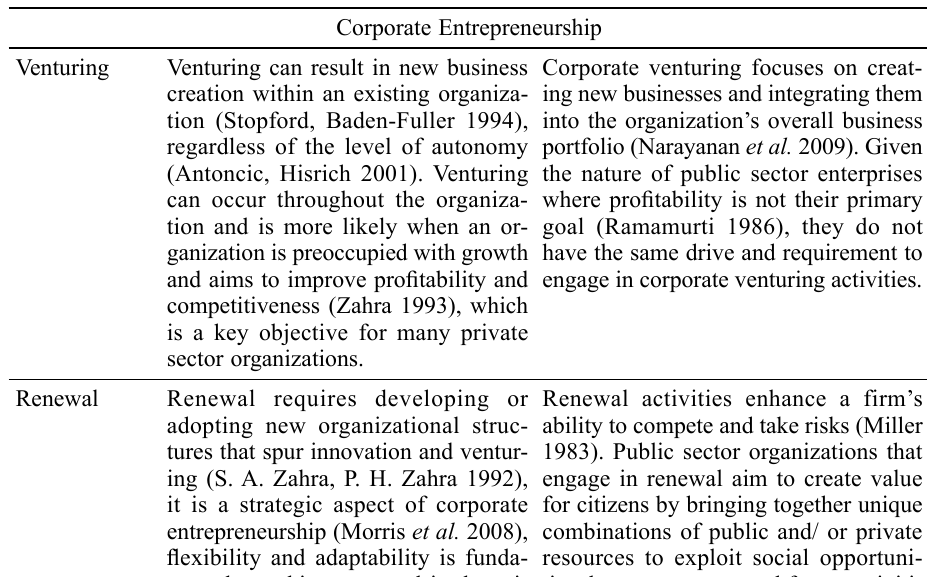
Table 1. Similarities and differences between private sector and public sector corporate entrepreneurship (emerging from the literature)